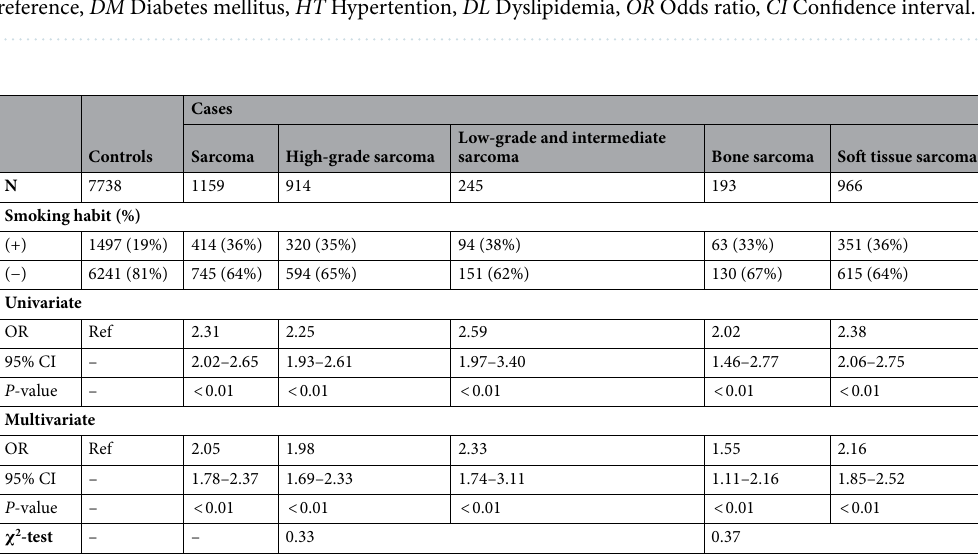
Table 5. Smoking rates in sarcoma patients of ≥ 20 years of age according to histological grade and disease origin. Ref reference, OR Odds ratio, CI Confidence interval.